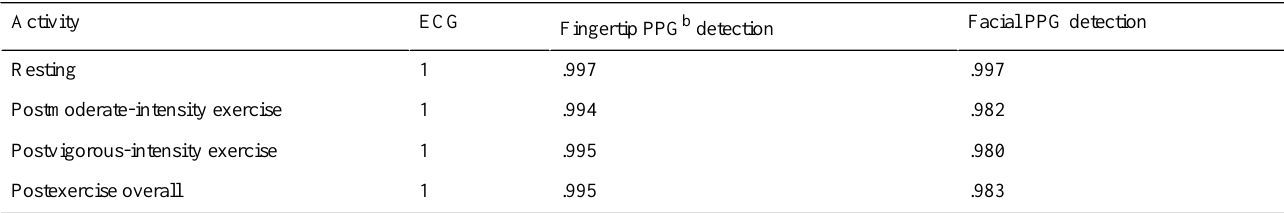
Table 4. Correlation test ( r ) a of heart rate between reference electrocardiogram (ECG) and Cardiio smartphone